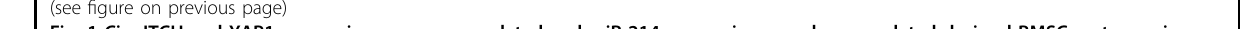
Fig. 1 Circ-ITCH and YAP1 expressions were upregulated and miR-214 expression was downregulated during hBMSCs osteogenic differentiation. Osteogenic differentiation of hBMSCs was evaluated by ALP staining ( A Scale bar: 100 μ m) and ALP activity assay ( B ) at 0, 7, and 14 days after osteogenic induction. C , D Calcium deposition determined by Alizarin red S staining (Scale bar: 200 μ m) and accumulation of mineralization on days 0, 7, and 14 after osteogenic induction. The mRNA and protein levels of osteogenic genes RUNX2, OPN, and OCN were determined by RT-qPCR ( E ) and western blot assay ( F ) at 0, 7, and 14 days. G The expression levels of circ-ITCH, miR-214, and YAP1 were determined by RT-qPCR after 0, 7, and 14 days of osteogenic culture. H The protein levels of YAP1 were determined by western blot assay after 0, 7, and 14 days of osteogenic culture. I Relative Circ-ITCH, miR-214, and YAP1 levels in 15 control (non-osteoporotic) samples and 15 osteoporotic samples. * P < 0.05, ** P < 0.01, and *** P <